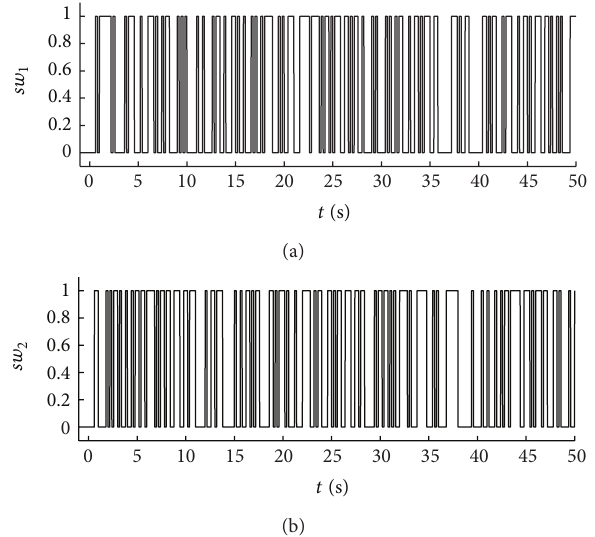
Figure 2: Time response of the switching variables 𝑠𝑤 1 and 𝑠𝑤 2 .